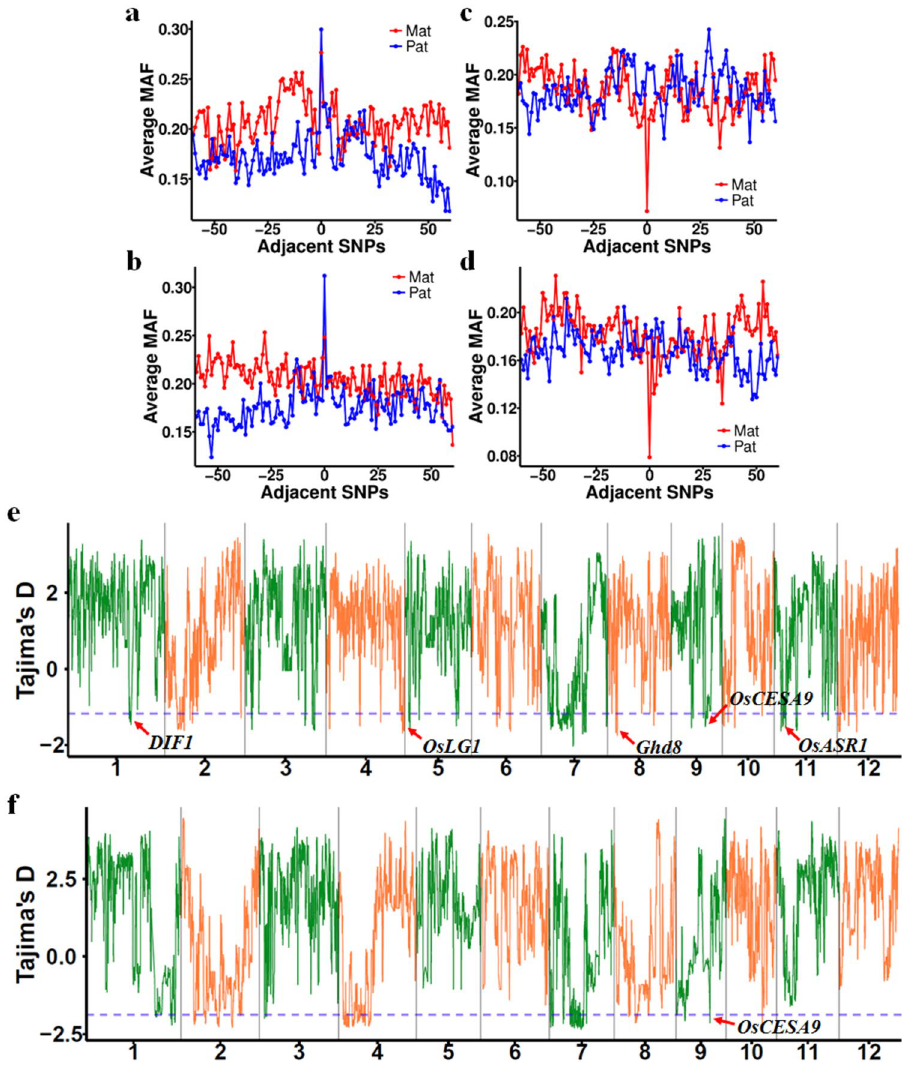
Figure 6. QTLs were under different selective pressure in male sterile lines and restorer lines. ( a–d ) Average MAF distributions around lead SNPs for three-genotype QTLs (a for CS, b for LS) and two-genotype QTLs (c for CS, d for LS). ( e,f ) Tajima’s D distribution across the whole genome of male sterile lines ( e ) and restorer lines ( f ). The blue dashed lines represent the 10th percentile of Tajima’s D in male sterile lines ( e ) and restorer lines ( f